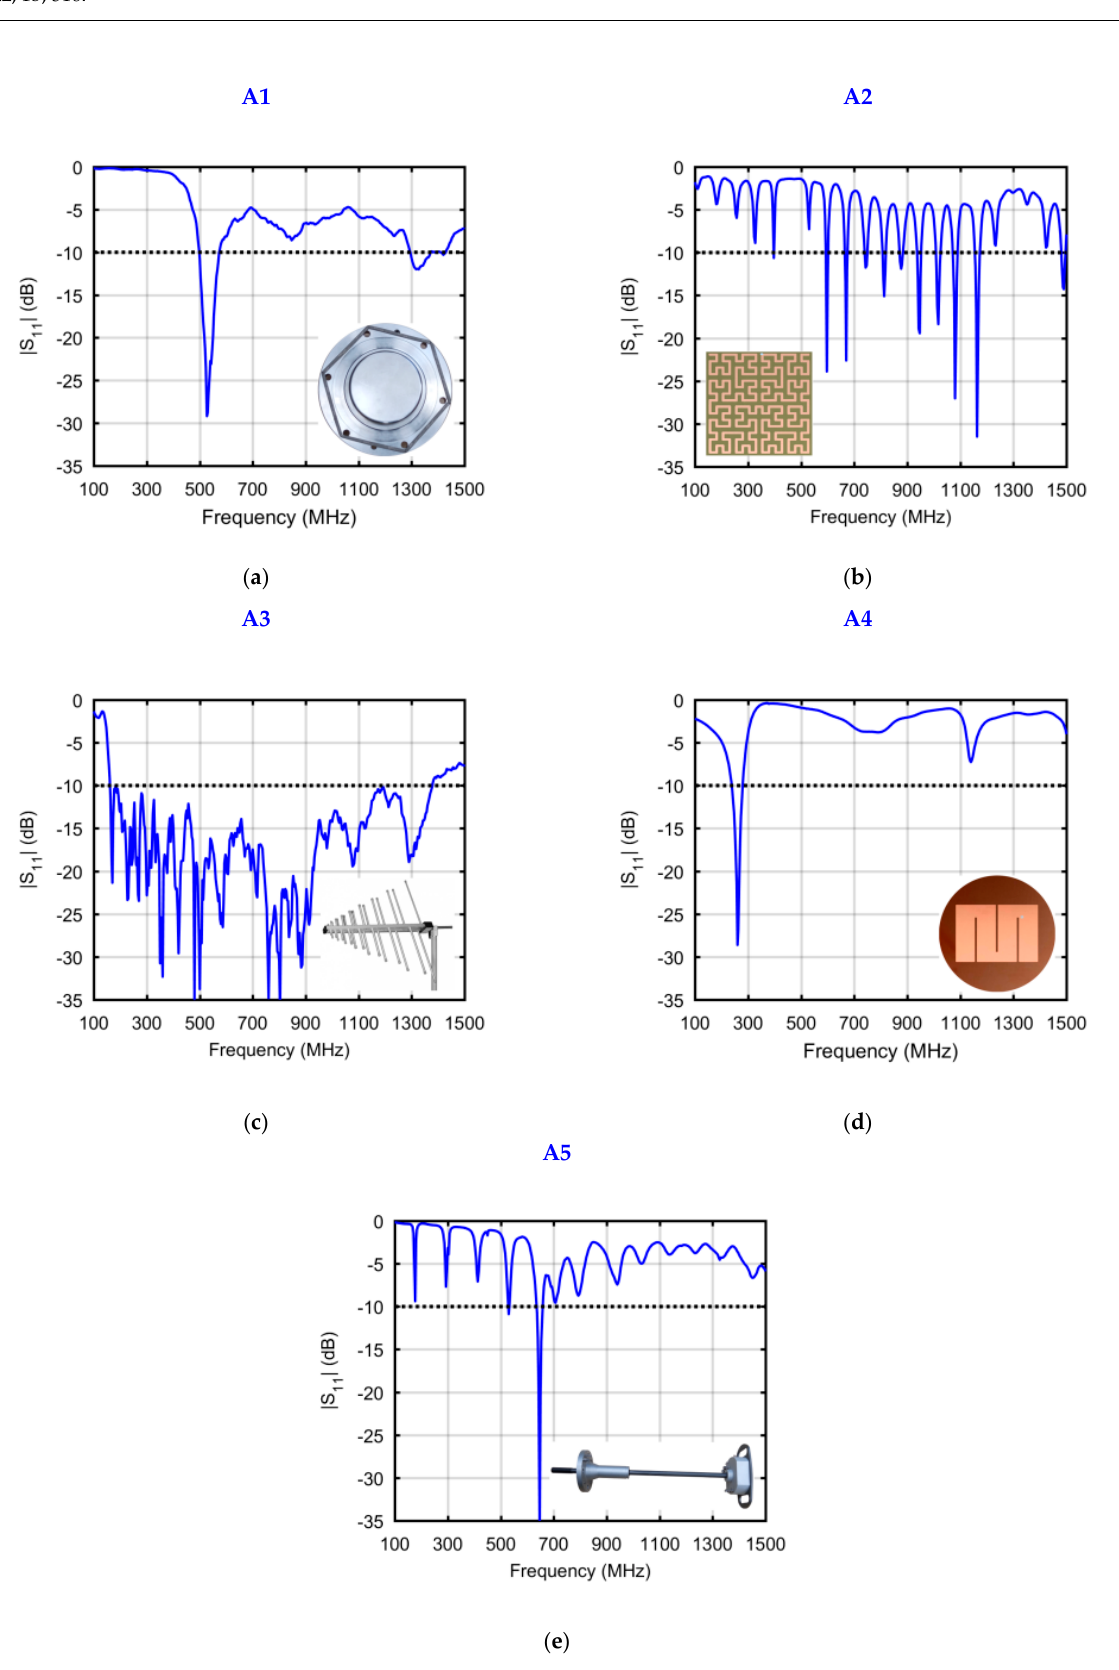
Figure 2. The measured return loss (S11) characteristics of the antennas used in the tests: ( a ) Disk sen- sor type Qualitrol IC43; ( b ) Hilbert curve fractal antenna; ( c ) Log-periodic antenna type Schwarzbeck VULP 9118 A; ( d ) Meandered planar inverted-F antenna; ( e ) Qualitrol UHF drain valve